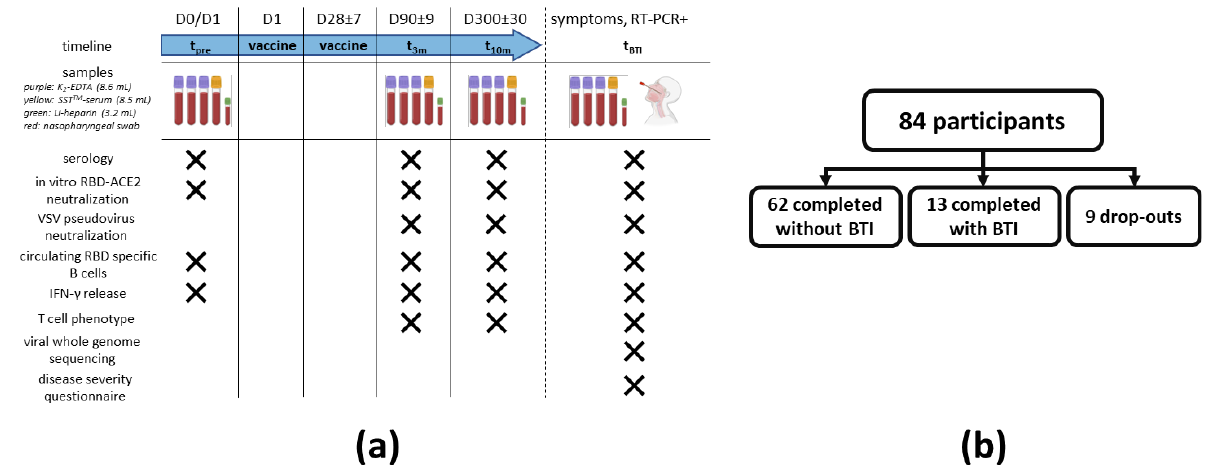
Figure 1. Study design and recruitment. ( a ) Maximum 24 h before receiving prime vaccination, a baseline sampling moment was scheduled (t pre ). A second and third sampling moment were planned between 80 and 100 days (t 3m ) and 270 and 330 days after baseline (t 10m ), respectively. On each timepoint, serum was collected to assess both SARS-CoV-2 serology and the antibody potency to inhibit RBD-ACE2 interaction (including in vitro and VSV pseudovirus neutralization assays), whereas whole blood from a random subset of participants was used to isolate PBMC to search for circulating RBD-specific B cells and to determine both SARS-CoV-2-specific IFN- γ release and T cell phenotype. When a fully vaccinated participant developed suggestive symptoms or had a prolonged high-risk contact and tested positive via RT-PCR, an additional sampling moment was planned (t BTI ). At t BTI , a disease severity questionnaire was also asked to fill in together with the collection of a nasopharyngeal swab to execute viral whole genome sequencing. ( b ) A total of 84 SARS-CoV-2-naive healthcare workers were enrolled. A schematic overview of the number of dropouts and participants that completed the study either without or with developing a RT-PCR- proven BTI is given. Abbreviations: RBD = viral receptor-binding domain, ACE2 = angiotensin converting enzyme 2 receptor, PBMC = peripheral blood mononuclear cells, IFN- γ =